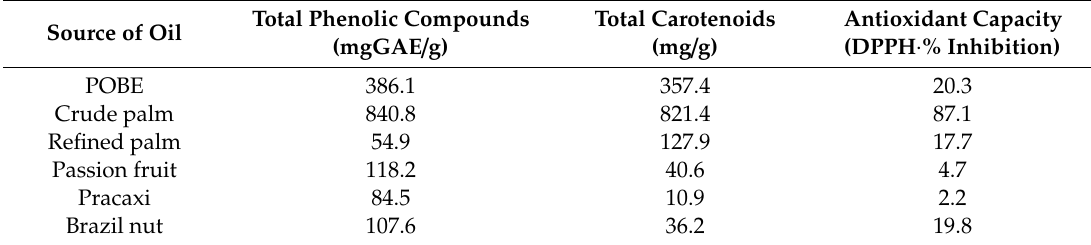
Table 3. Bioactive compounds of the palm oil bleaching extract (POBE) compared with those of other vegetable